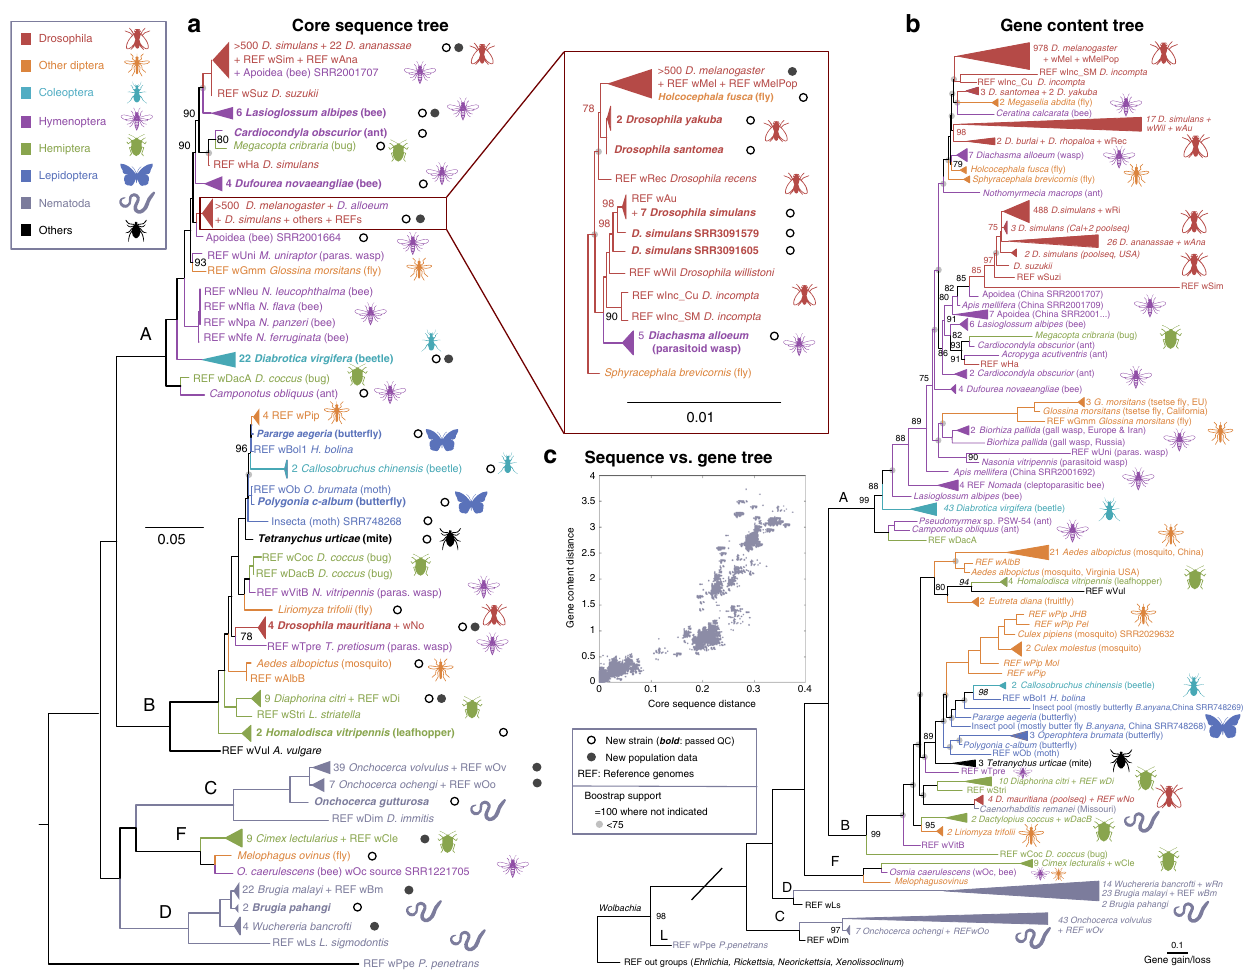
Fig. 2 Whole-genome phylogenies of Wolbachia . a Maximum likelihood tree of 313 core genes alignment employing 339,972 nucleotide positions from 1161 newly assembled genomes (1005 genomes complied with our quality criteria plus 156 of core gene quality, see “ Methods ” section and Supplementary Data 2). Larger clades have been collapsed and their subtrees are represented by triangles. Bold host species indicate assembled genomes that ful fi lled our quality requirements. The complete tree including support values is available in Newick format (Supplementary Data 1). b Functional potential tree based on presence and absence of 6376 gene families in 1793 Wolbachia positive samples as inferred by PanPhlAn. Gene families present in <5 Wolbachia positive samples were not considered. Both trees were inferred with RAxML using the GTR + G model of replacement and the BINGAMMA model, respectively, in both cases bootstrapping with 100 pseudo-replicates (for support see legend). c Scatterplot showing pairwise distances between all possible genome pairs in the core gene sequences (tree in a ) versus identical pairs in the binary tree based on gene presence ( b ). Animal silhouettes have been created by Wolbachia - Drosophila symbiotic models. We further identi fi ed a dubious new strain in the nematode Caenorhabditis remanei with a 98.04% identity in gene content with w No of D. mauritiana